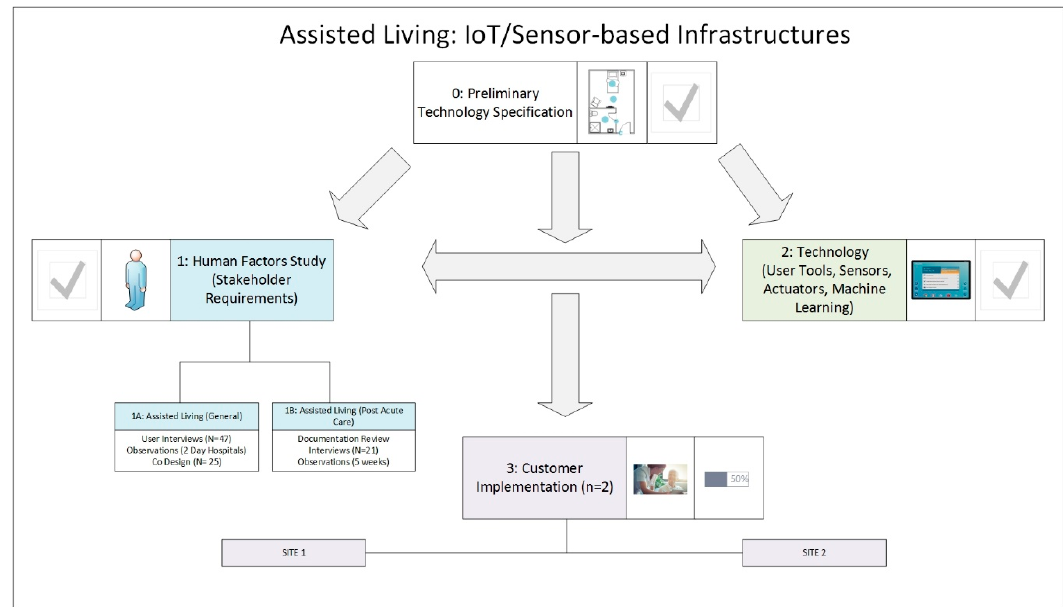
Figure 1. Overview of the three studies.